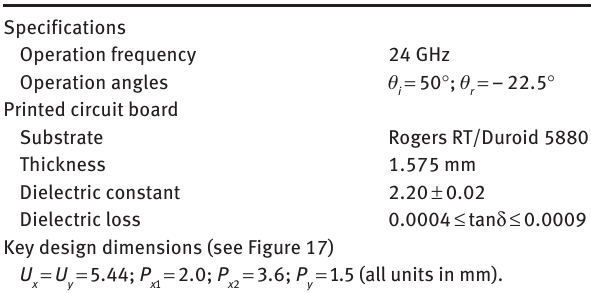
Table 1: Specifications and key dimensions for the perfect anoma- lous reflection binary